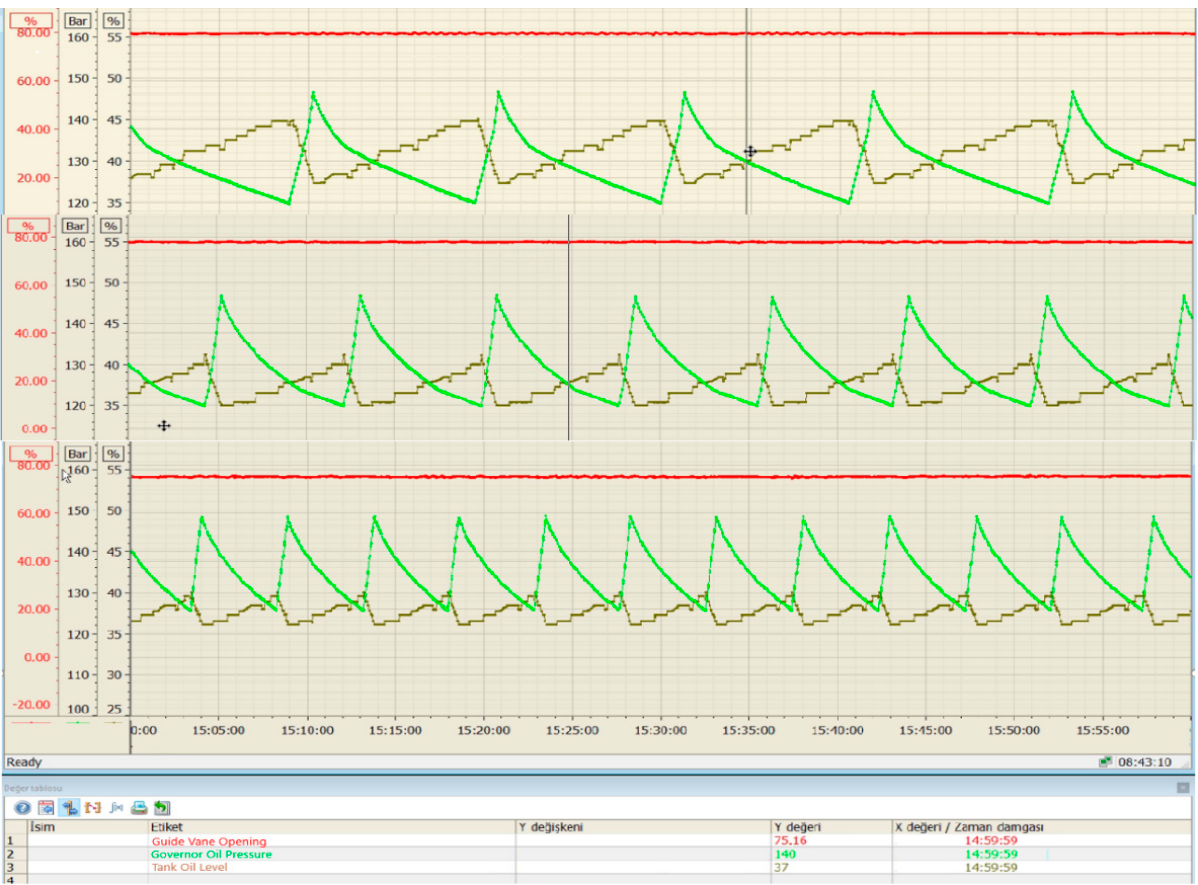
Figure 2. An example of failure in a governor hydraulic unit without any warning.